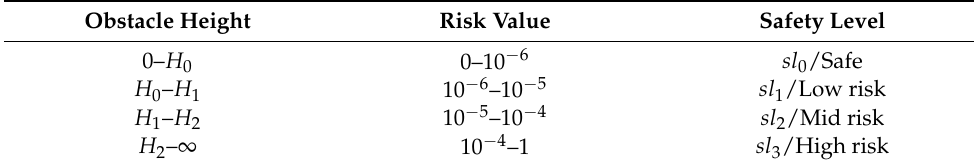
Table 3. Obstacle height